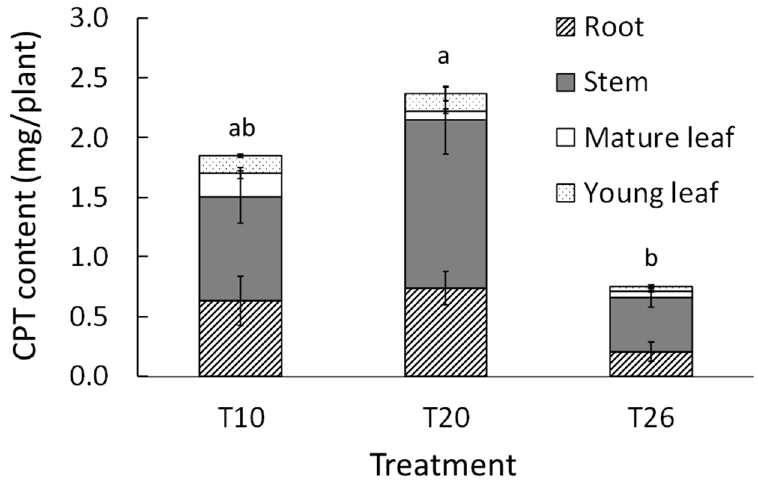
Figure 7. Effects of nutrient solution temperature (NST) on the camptothecin (CPT) content in the whole O. pumila plant at 35 days after the start of the treatment (DAT) in experiment 2. The NST treatments were set at 10, 20, and 26 °C as T10, T20, and T26, respectively. The NSTs at T10 and T20 were maintained using a handy cooler, and that at T26 was not controlled. The CPT content was calculated using the CPT concentration determined by HPLC and the dry weight of each organ. Vertical bars indicate S.E. ( n = 3). Different letters indicate significant differences among the treatments at p < 0.05 by Tukey–Kramer’s test.